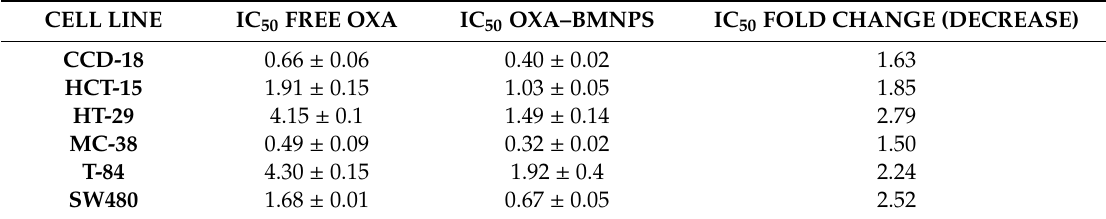
Table 1. IC 50 value of free oxaliplatin (Oxa) and Oxa–biomimetic magnetic nanoparticles (BMNPs) in the cell lines tested.